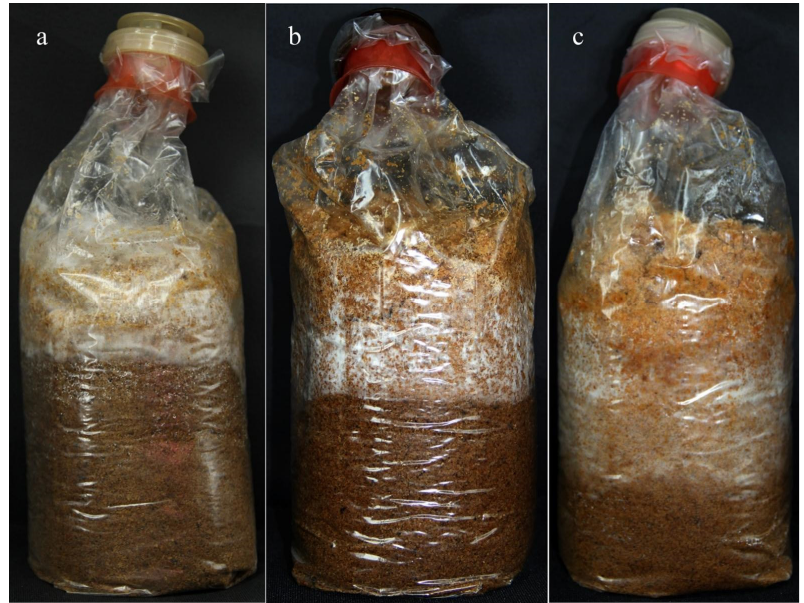
Figure 5. Growth of the S. latifolia mycelium in PSM. ( a ) Growth of the S. latifolia mycelium in PSM supplemented with 10 mM OA; ( b ) growth of the S. latifolia mycelium in PSM; ( c ) growth of the S. latifolia mycelium in PSM supplemented with 4 mM OA - .